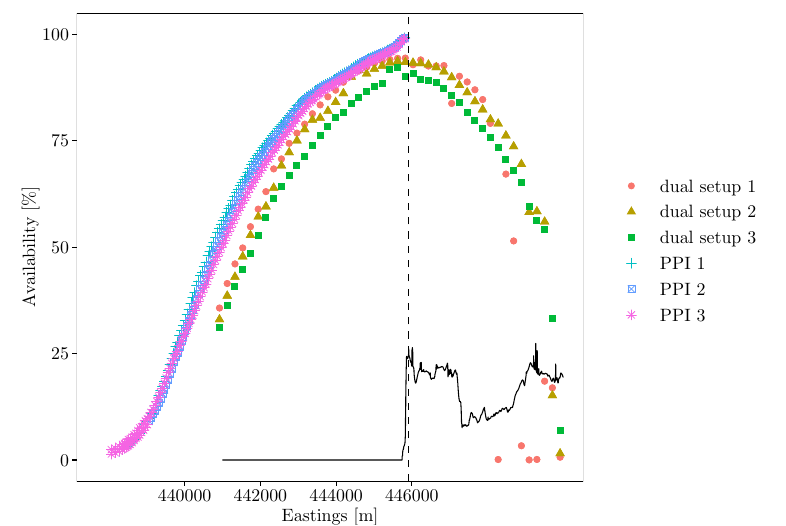
Figure 7. Actual availability of reconstructed wind speed components as a function of eastward position. The numbers 1, 2, and 3 refer to the vertical level of measurements of the PPI and dual setups. The dashed line indicates position 2 and the solid line is the height of the terrain (not to